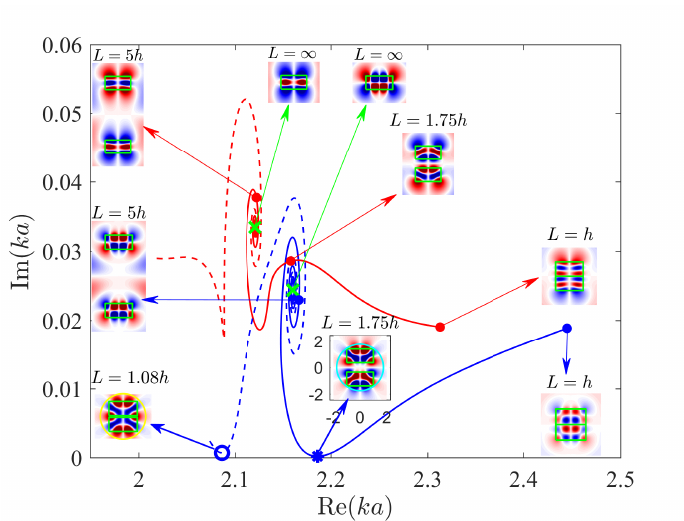
Figure 6. Avoided crossing of resonances originated from coupling of orthogonal resonances of isolated disk shown in Figure 2a for variation of distance between disks for a = 0.5 µ m, a / h = 0.96. Solid/dash lines show the anti-bonding/bonding resonances. Insets show the profiles of tangential component of electric field E φ